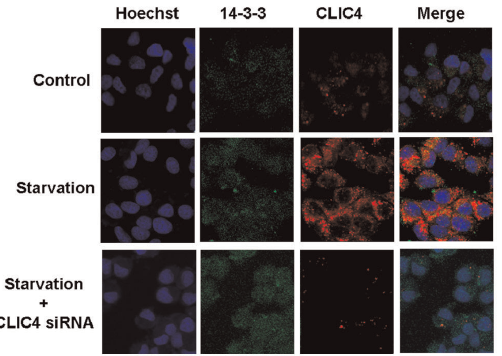
Figure 8. Inhibition of CLIC4 decreased co-localization of 14-3- 3 epsilon and CLIC4 under starvation conditions. CLIC4 siRNA- transfected U251 cells for 24 h. Co-localization of 14-3-3 epsilon (green) and CLIC4 (red) were observed by confocal microscopy in U251 cells incubated with EBSS for 8 h (600 6 ).